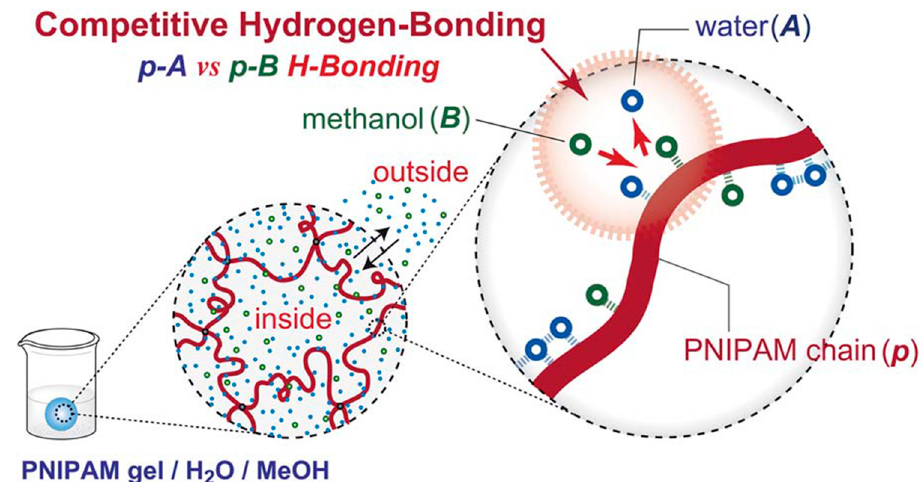
Figure 5. Model of competitive hydrogen-bond formation between polymer–water ( p – A ) and polymer–methanol ( p – B ) of PNIPAAm in both mixed solvents, proposed by Kojima and Tanaka. Reprinted with permission from Reference [67]. Copyright © 2012 The Royal Society of Chemistry.